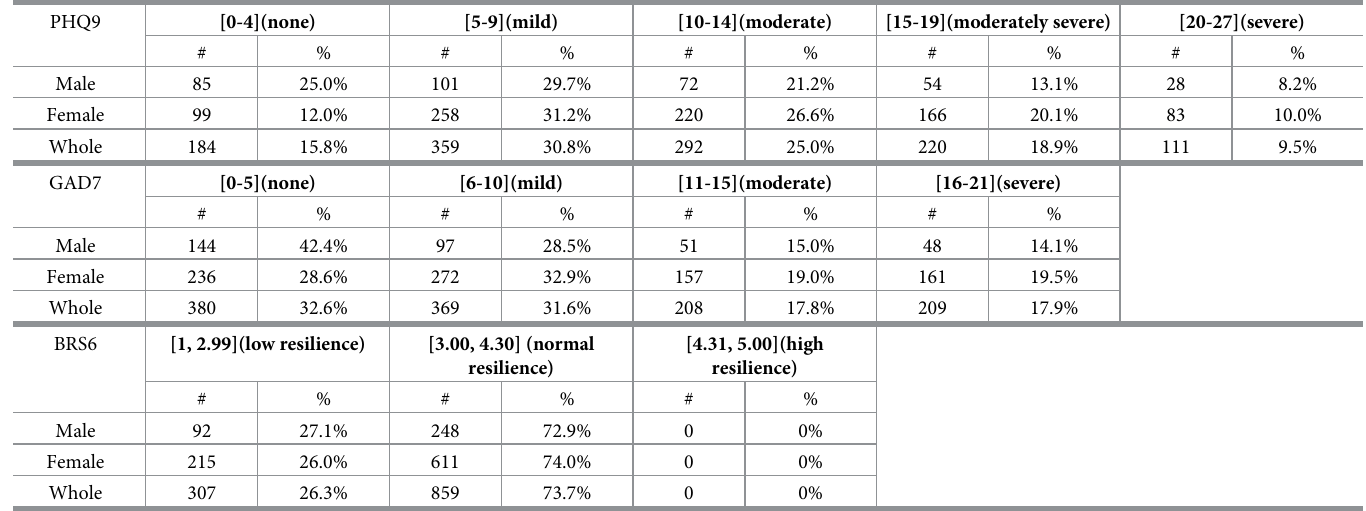
Table 10. Detailed distributions of PHQ9, GAD7 and BRS6.